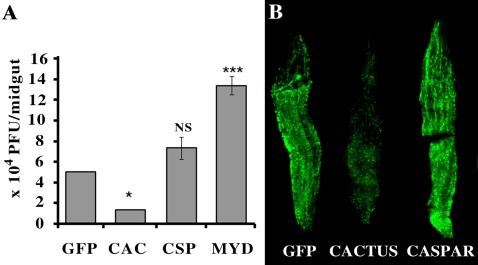
Rel1 regulate anti-dengue activity.Dengue virus loads in the midguts of Cactus, Caspar and MyD88 depleted mosquitoes, and GFP dsRNA treated control mosquitoes. A. Virus titers were measured by plaque assay in C6/36 cell. *, P<0.05, ***, P<0.001, in Student's t-test comparing to GFP control. B. Virus load is assayed through indirect immunofluorescence assay (IFA) in infected midguts. Error bar represents standard error.